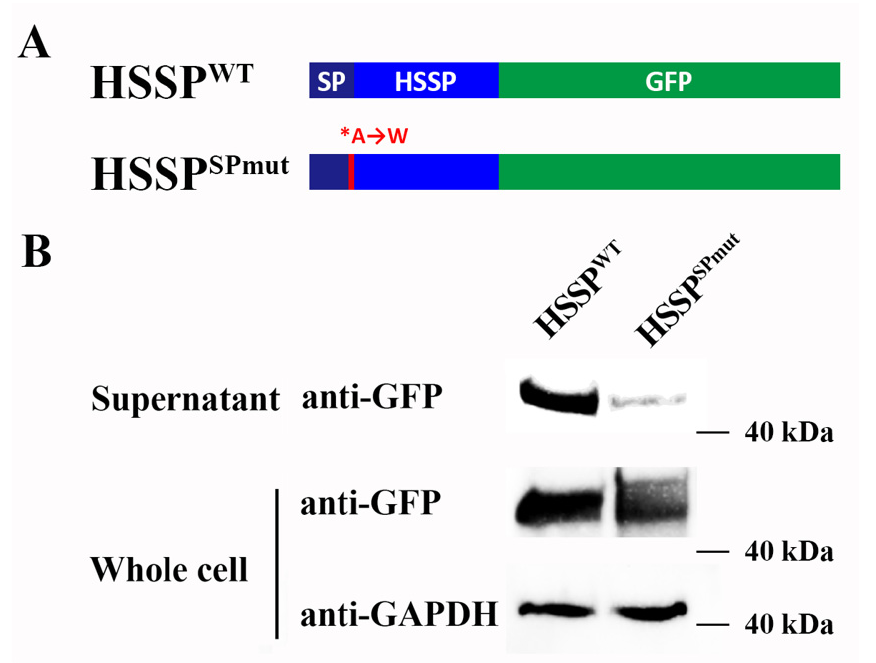
Figure 3. LvHSSP signal peptide sequence drove secretion. ( A ) Diagram of the GFP fusion constructs used for transfection. The 19th A residue in the signal peptide of LvHSSP (LvHSSP WT ) is mutated to W (LvHSSP SPmut ). ( B ) Western blotting results showed that transfection with plasmids encoding LvHSSP-GFP fusion proteins revealed that the wild-type LvHSSP signal peptide sequence (HSSP WT ) drove secretion (band of GFP in the supernatant), whereas mutation of A → W in the signal peptide cleavage site (HSSP SPmut ) caused the reduction of signals in the supernatant. Tissue distribution of LvHSSP in shrimp was analyzed by RT-PCR, and the results showed that the transcripts of LvHSSP were specifically expressed in hemocytes (Figure 4A). Transcriptome data showed that LvHSSP was highly expressed in hyalinocytes and semi-granulocytes (Figure 4B). To determine whether LvHSSP is responsive to WSSV in- fection, the expression pattern of LvHSSP in the hemocytes of shrimp during WSSV infec- tion was analyzed by qPCR. The expression of LvHSSP significantly decreased in hemo- cytes at 3 hpi and 6 hpi, but significantly increased at 24 hpi and 48 hpi (Figure 5). These results suggested that LvHSSP was a hemocyte-specific secretory protein and might be involved in viral infection in shrimp.